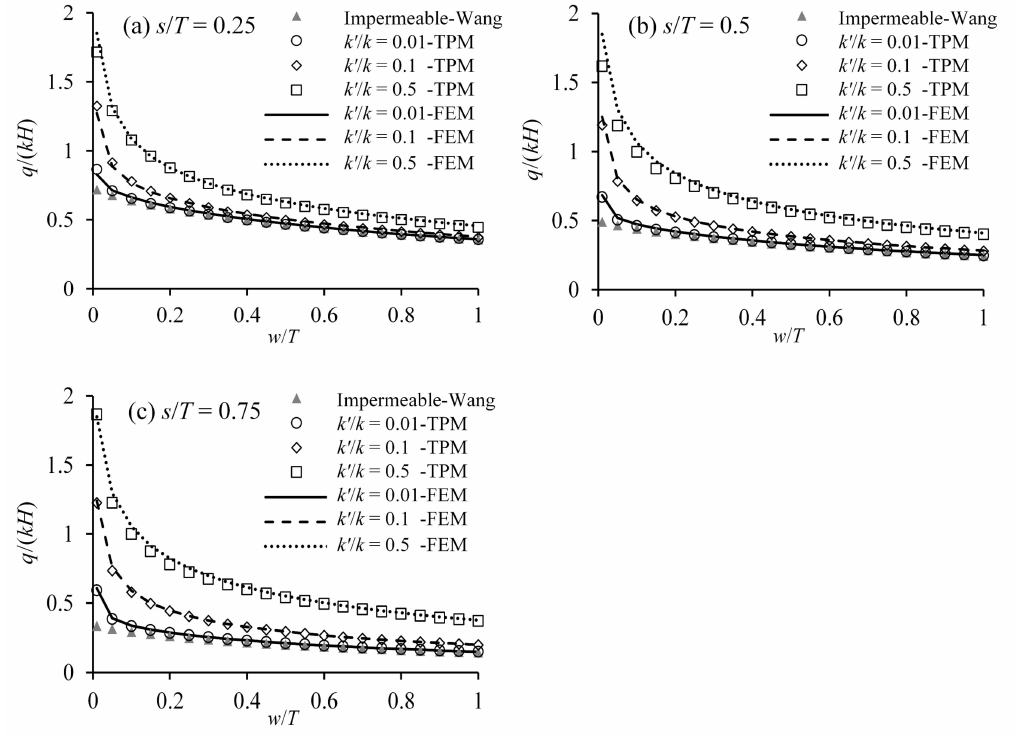
Figure 12. Comparisons of flow calculation results among Wang, TPM, and FEM for ( a ) s / T = 0.25, ( b ) s / T = 0. 5, and ( c ) s / T =